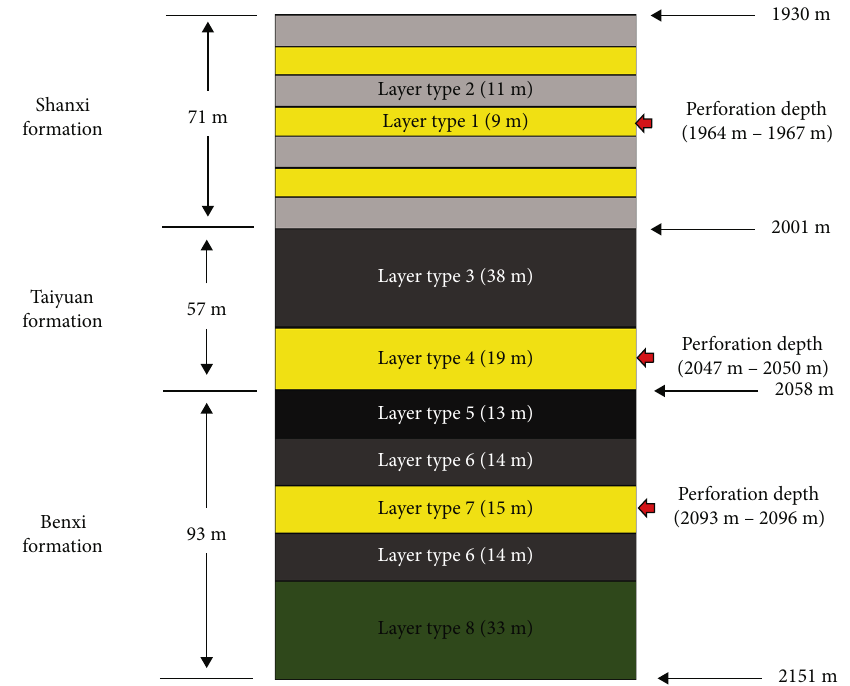
Figure 3: The concept model of the multilayered thin tight gas reservoir.